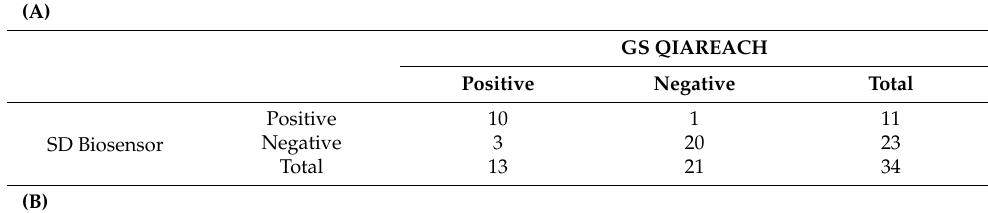
Table 3. (A). Comparison between the new IGRA technique and the gold standard. Samples collected from HBLT patients under 36 (September to December 2022). ( n = 34). (B). Comparison between QIAreach and TST. Samples collected from HBLT patients under 36 years of age (September to December 2022) ( n = 34). (C). Comparison between the new IGRA technique (SD BIOSENSOR) and TST. Samples collected from HBLT patients under 36 years of age, (September to December 2022) ( n = 34).